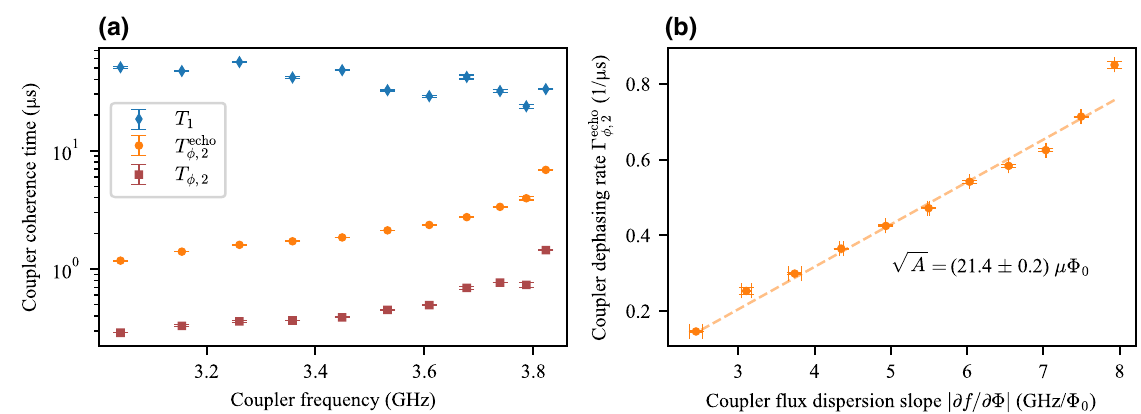
FIG. 11. (a) The experimentally obtained relaxation and coherence times of the coupler as functions of its frequency. (b) The pure dephasing rate from echo measurements as a function of the flux-dispersion slope. A line fit yields the flux-noise amplitude